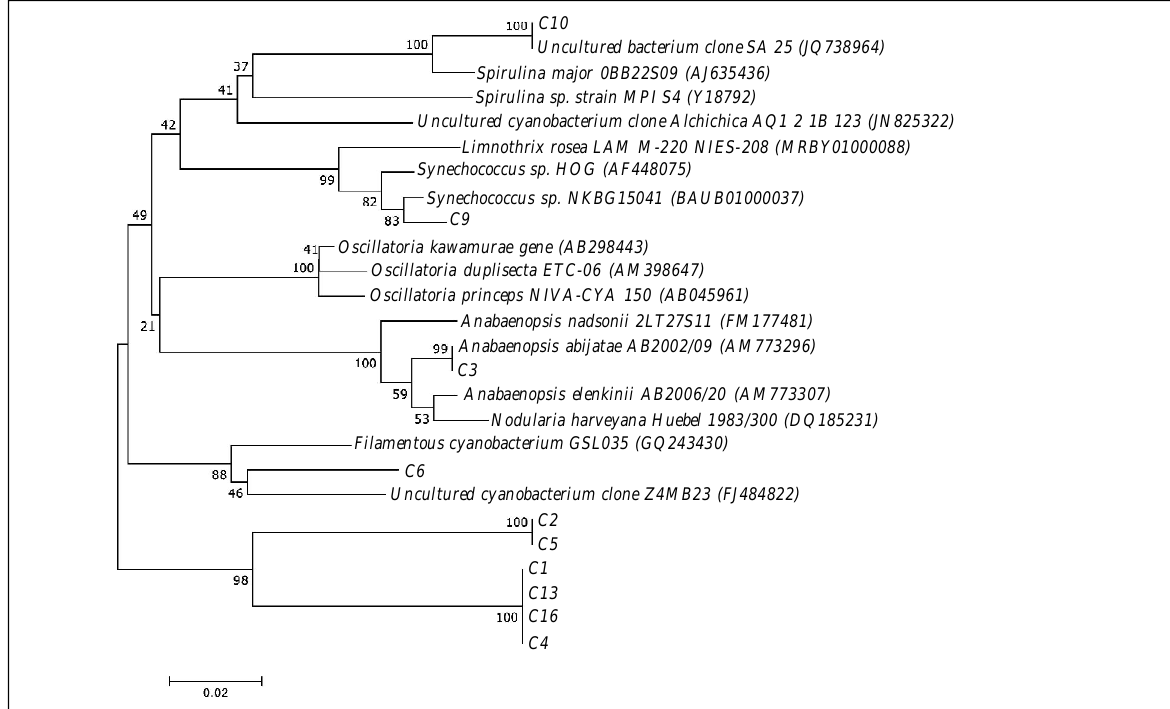
Figure 4: Unrooted phylogenetic tree showing the relatedness of the cultured cyanobacterial isolates to closest